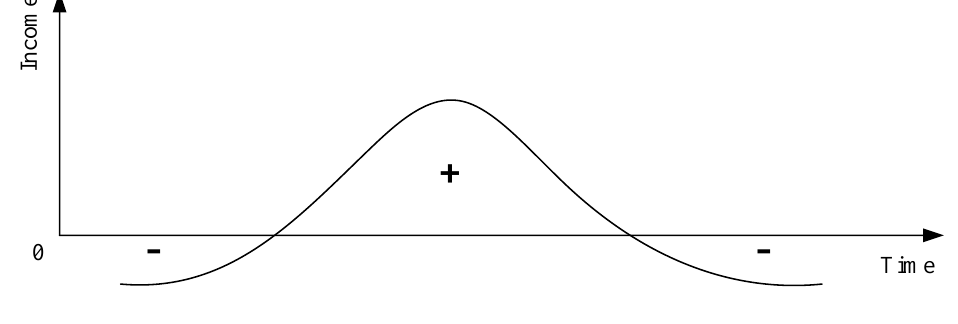
Figure 1. Effect of the standard